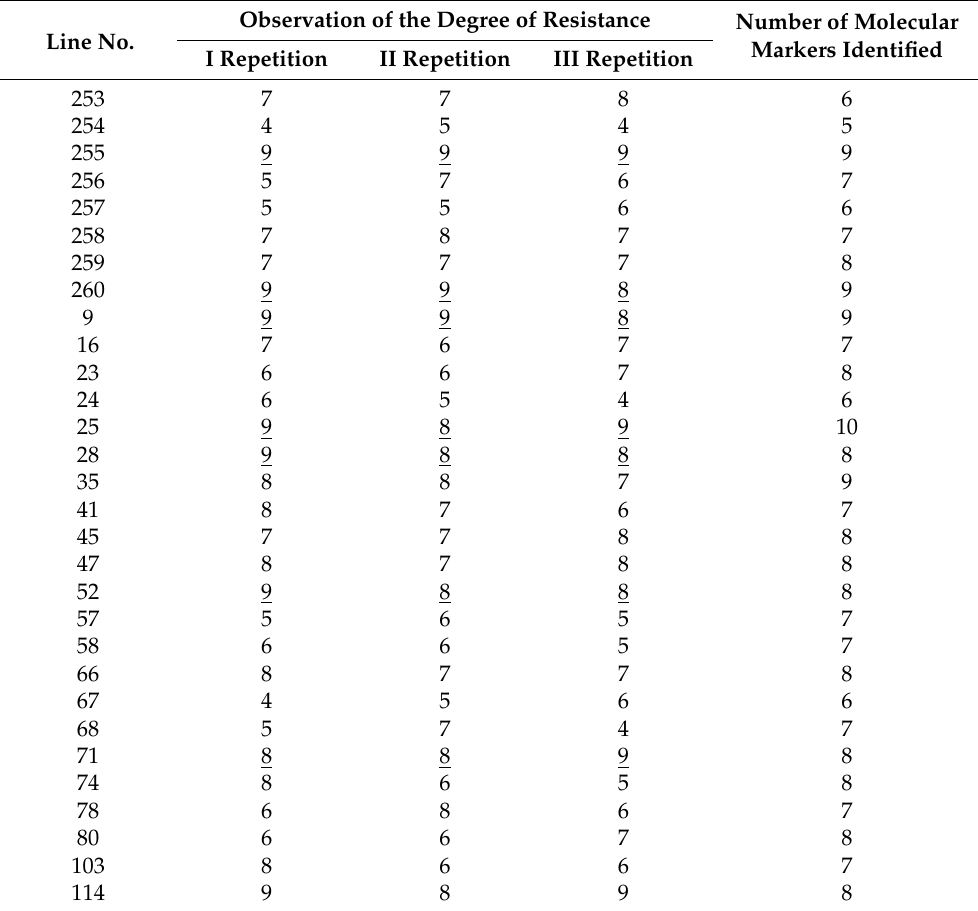
Table 3. Degree of Fusarium verticillioides infection of individual genotypes and number of identi- fied markers. Observation of the Degree of Line No.